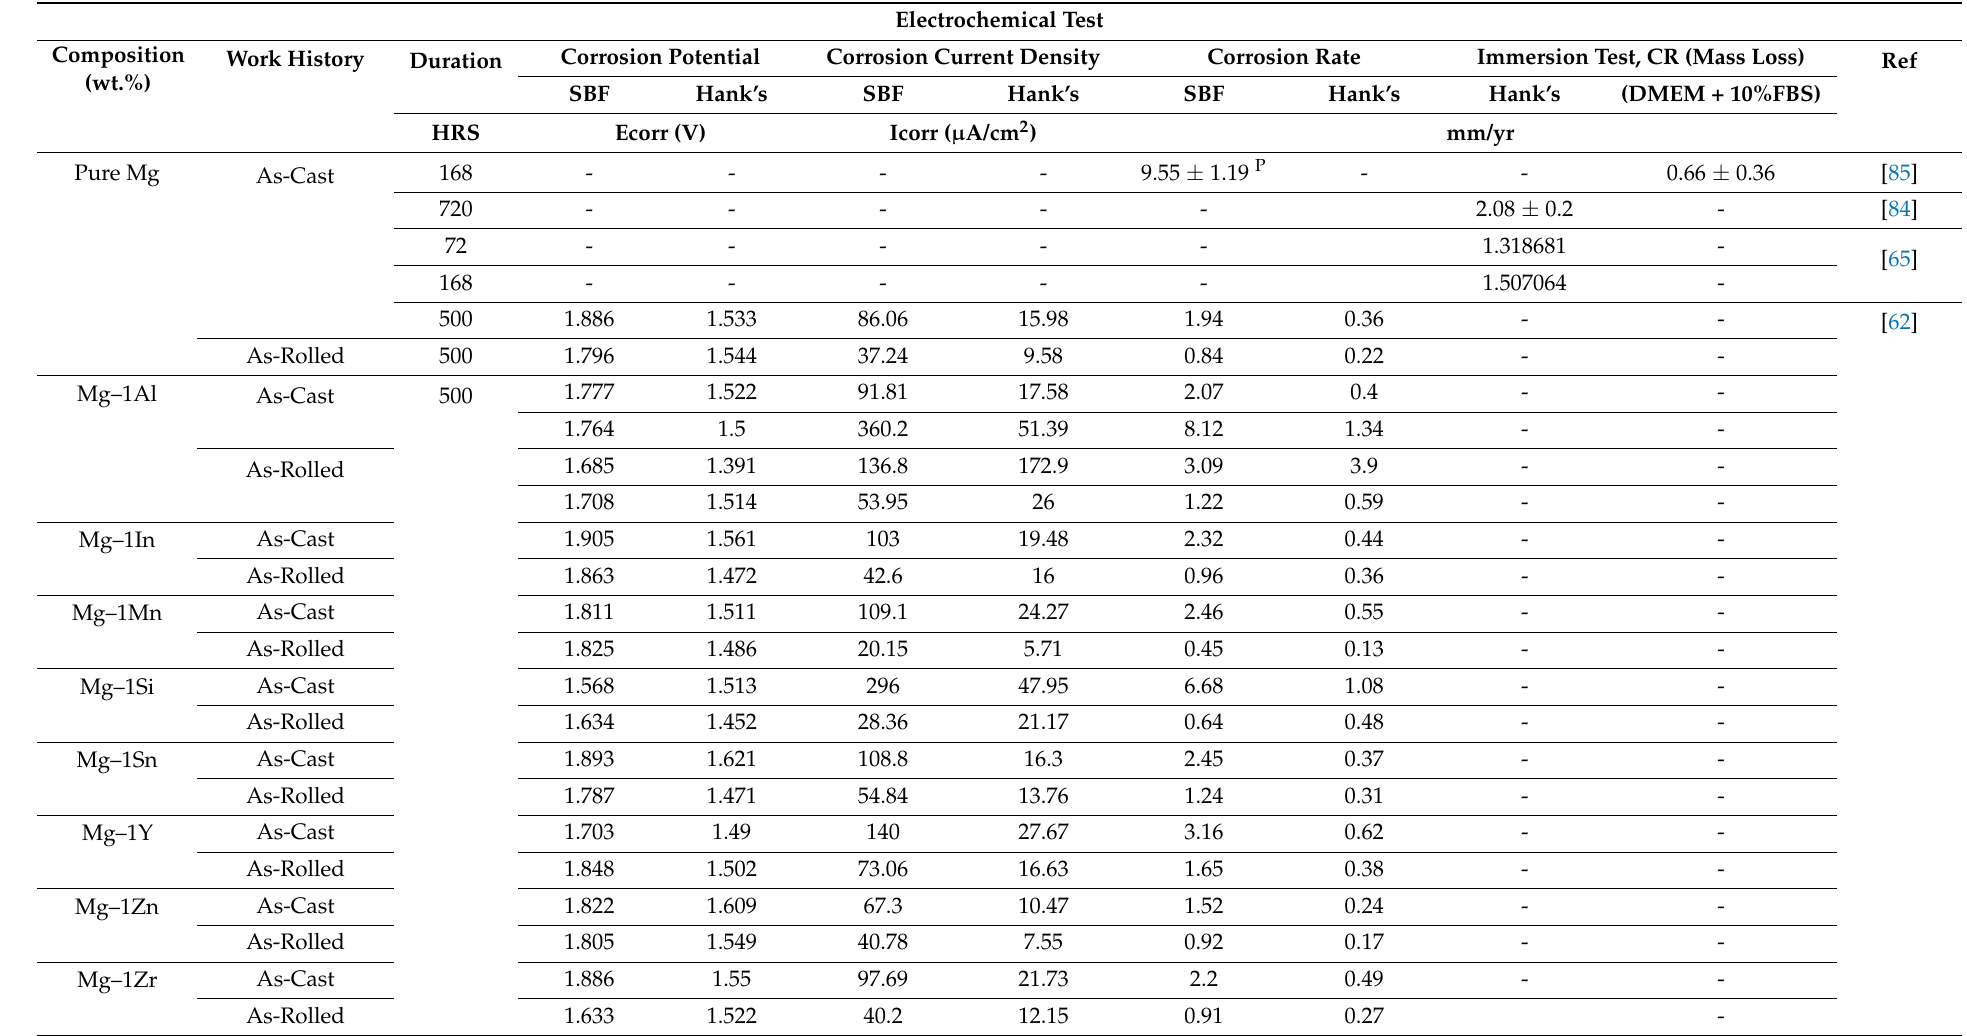
Table 4. A compilation of some of the favorable degradation rates of binary alloys of biodegradable Mg alloys along with their work history as found in literature. Electrochemical